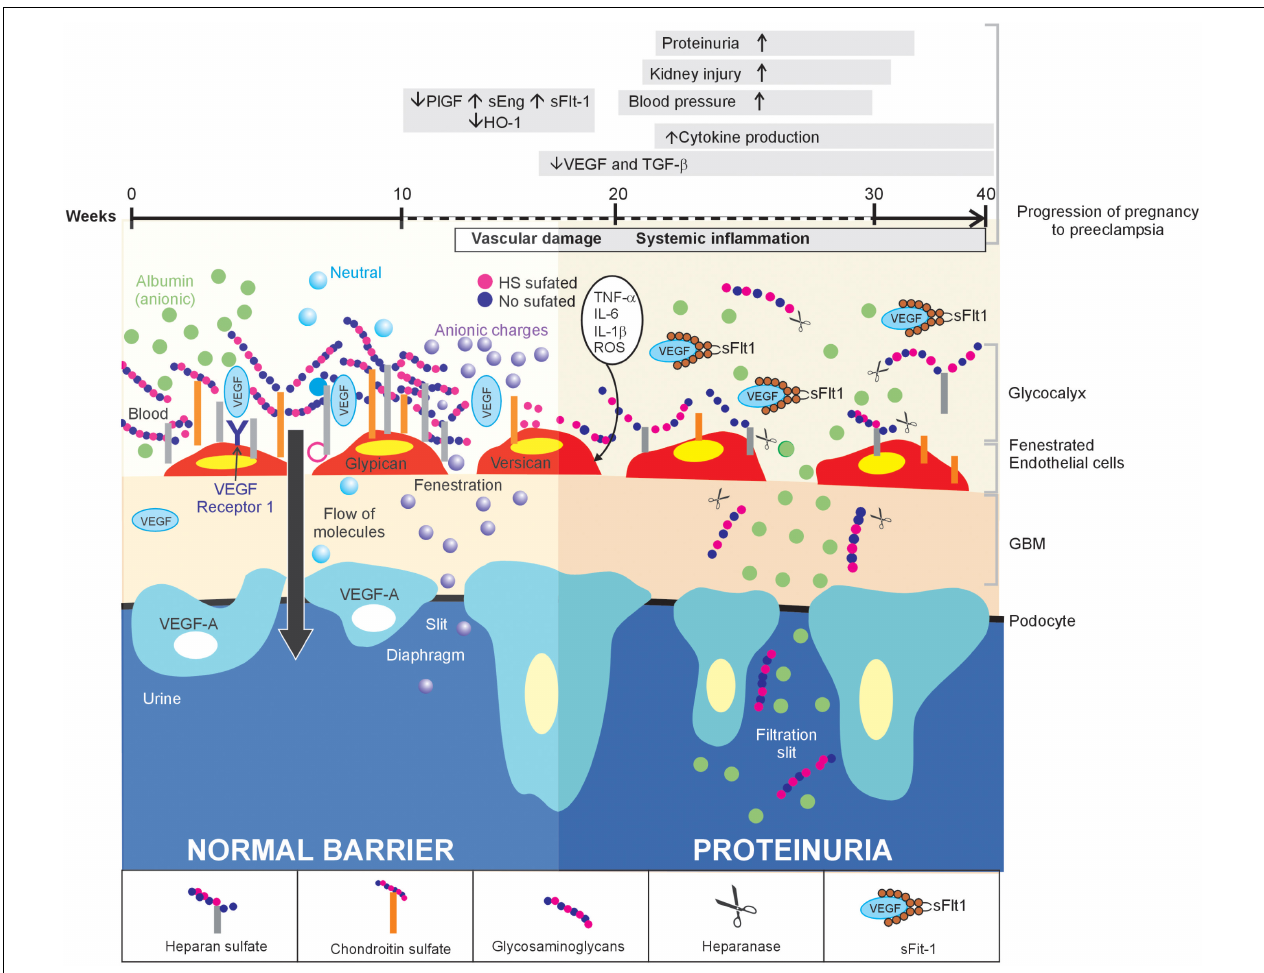
FIGURE 1 | Inflammation of the glomerular endothelium causes the loss of HS, thereby triggering proteinuria in women with PE: a proposed model. In normal conditions (left side), the GFB performs its function of filtration, which is characterized by selective permeability to albumin due to HS in the glomerular endothelial glycocalyx, through its three layers. When a glomerular endothelial inflammation is established (right side), as is the case of PE, the increase in pro-inflammatory cytokines promotes the heparanase-mediated endoglucosidic activity of HS, which leads to the loss of anionic sites and, consequently,